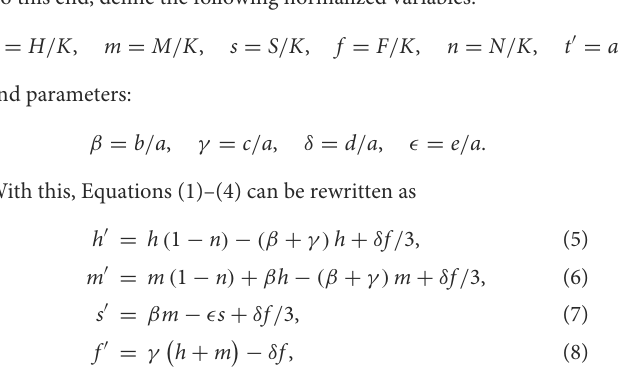
S . Severely damaged mitochondria are degraded via mitophagy; a process that is also assumed to be linear. Given that fusion is 9 m - dependent (with 9 m the potential across the mitochodrial inner membrane), we assume that only healthy and moderately damaged mitochondria may fuse. The rate at which fusion takes place is assumed to be proportional to the mitochondrial volume